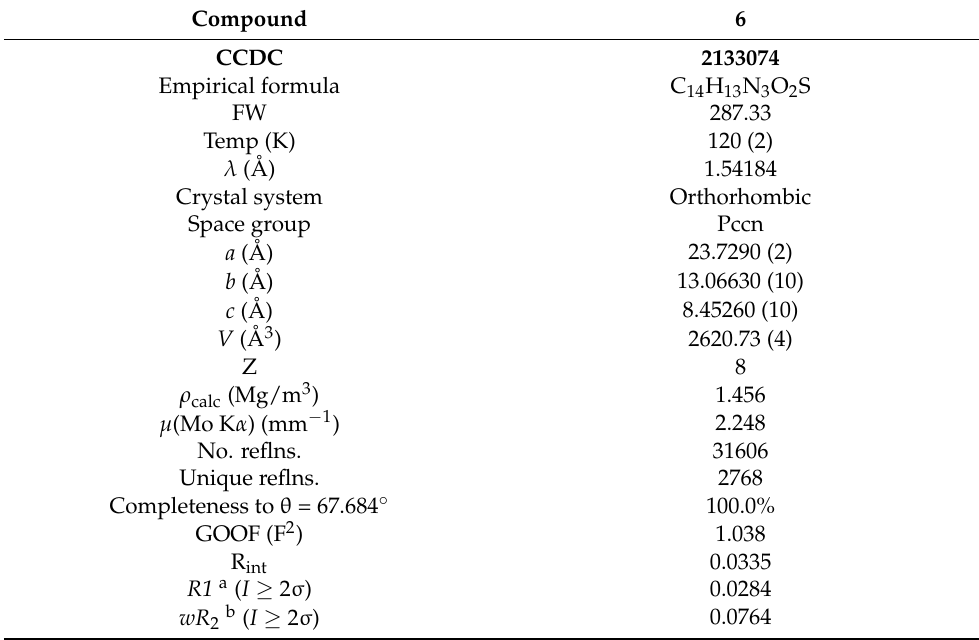
Table 1. Crystal data set of target molecule 6 .